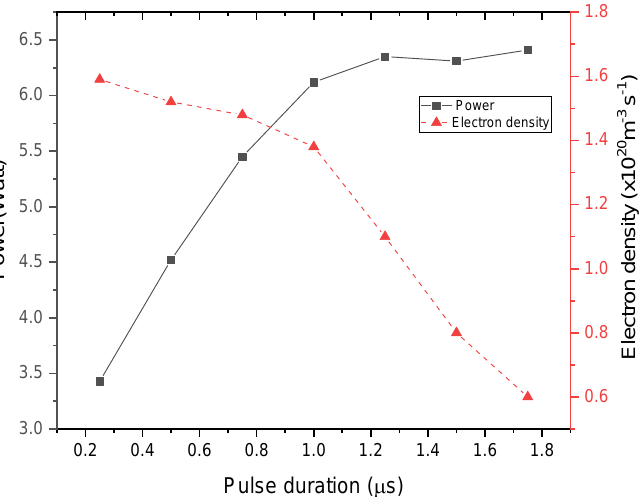
Figure 7. Evolution of electric power consumption and electron number density with different pulse duration. Voltage magnitude of 10 kV, pulse duration of 1 µs with repetition rate of 10 kHz.